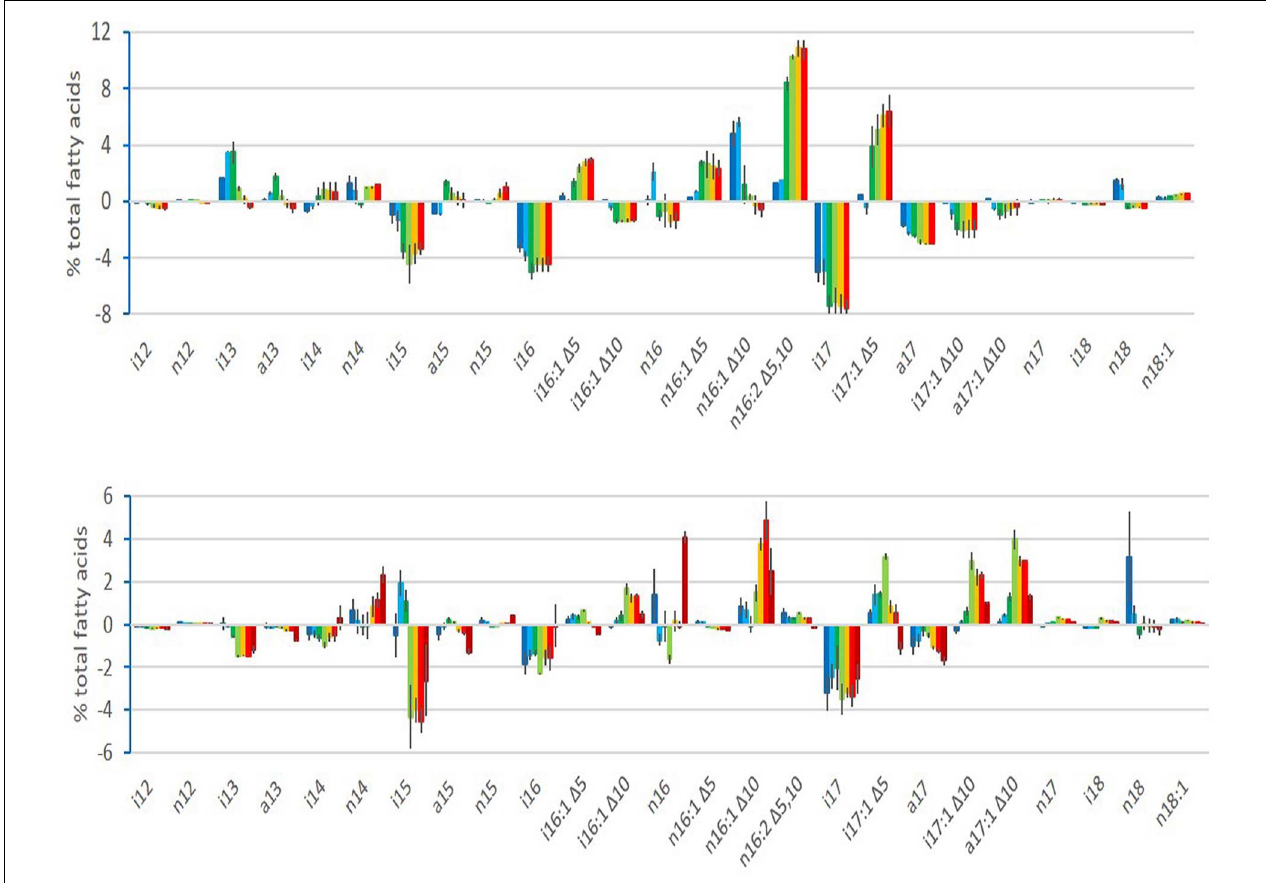
FIGURE 2 | Changes in relative abundance (%) of fatty acids during growth of B. cereus strain ATCC 10876 at cold temperature (12 ◦ C, upper panel) and warm temperature (30 ◦ C, lower panel), relatively to the inoculum. Bars represent mean of three independent experiments and present for each growth time fatty acid relative abundance minus fatty acid relative abundance of inoculum. Lines over or below bars are standard deviations. For each fatty acid, growth times were, from left to right, 3, 7, 24, 48, 72, and 96 h at 12 ◦ C and 0.5, 1, 2, 4, 6, 7, and 24 h at 30 ◦ C. Colors ranged from dark blue for first sampling time to red for sixth (brown for the seventh at 30 ◦ C) sampling